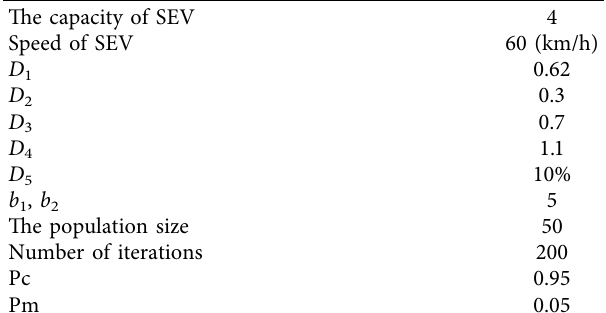
Table 2: Parameters in the model and